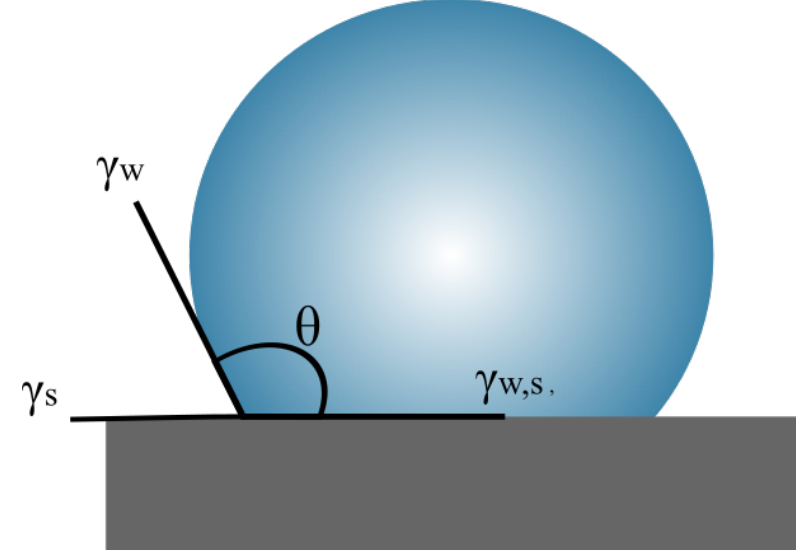
Figure 1. Illustration of the most general water contact angle θ . The surface energies γ correspond to the parameters of Young’s equation in Equation (1), where γ w , s , γ s and γ w refer to the specific energies of the solid–water, solid–vapour and water–vapour interfaces,